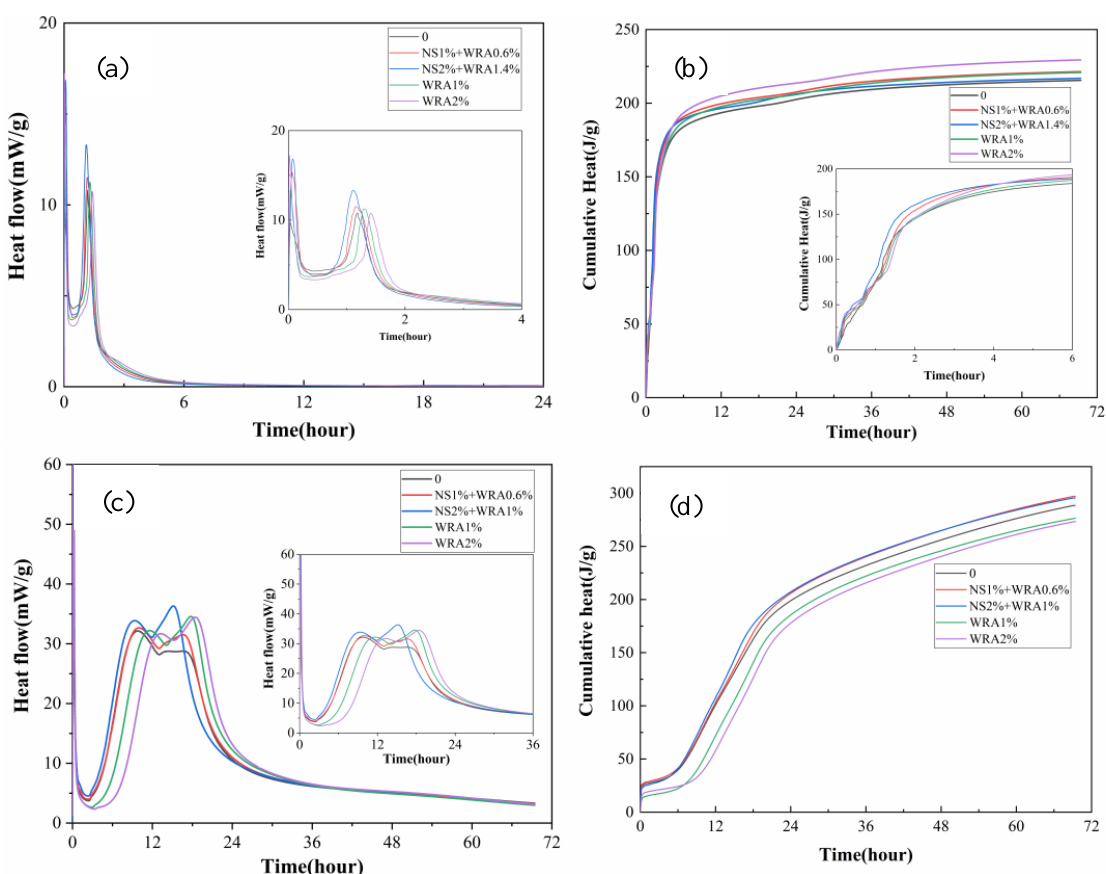
Figure 2. Hydration heat curves of the series cement with nanosilica sol: ( a ) heat flow curve of HBSAC cement; ( b ) cumulative heat curve of HBSAC cement; ( c ) heat flow curve of P · O 42.5 cement; ( d ) cumulative heat curve of P·O 42.5 cement.